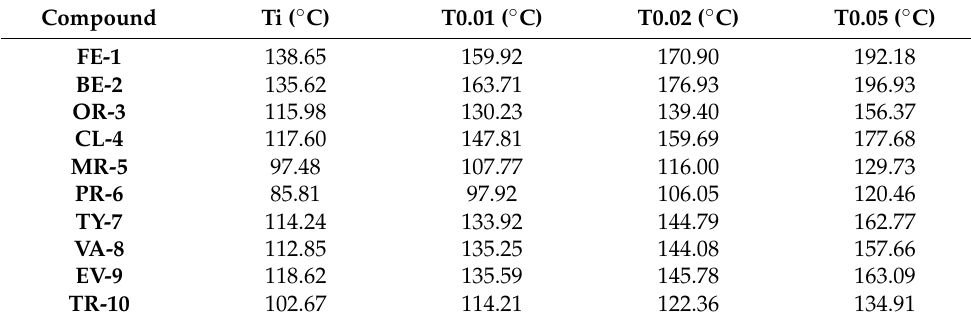
Table 3. Thermal stability for obtained ionic